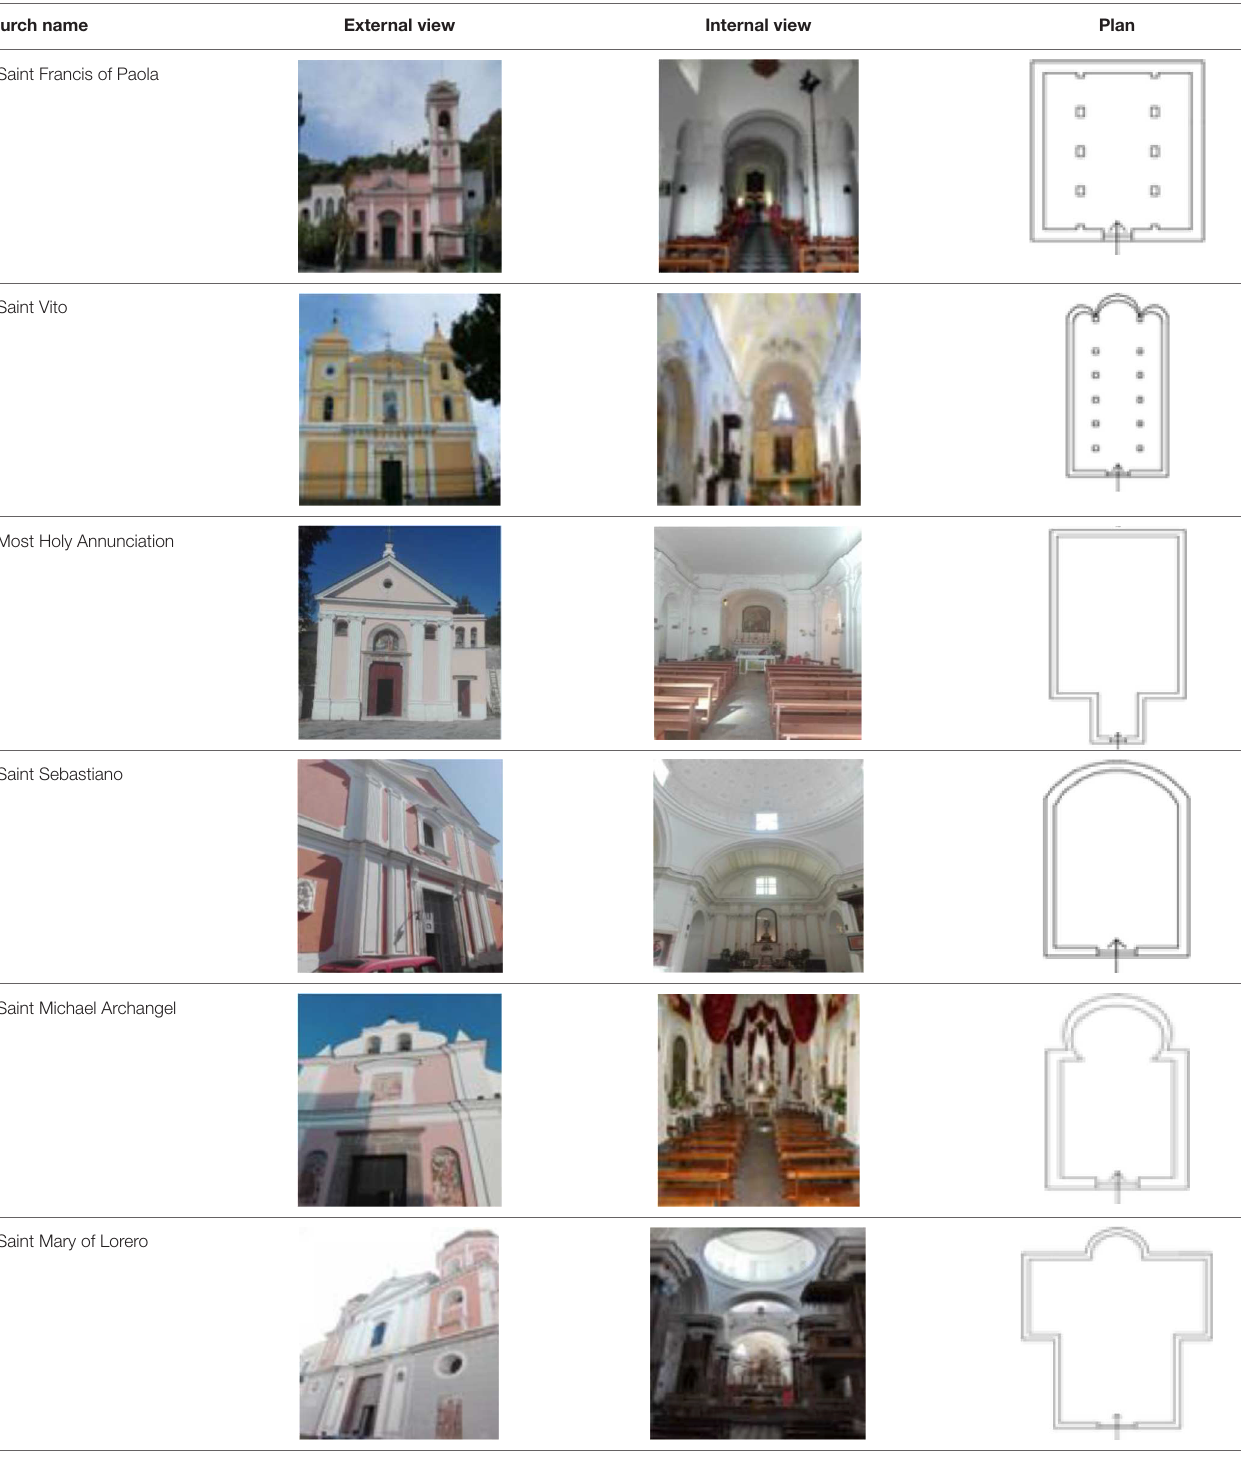
TABLE 5 | Geometrical features of churches investigated in